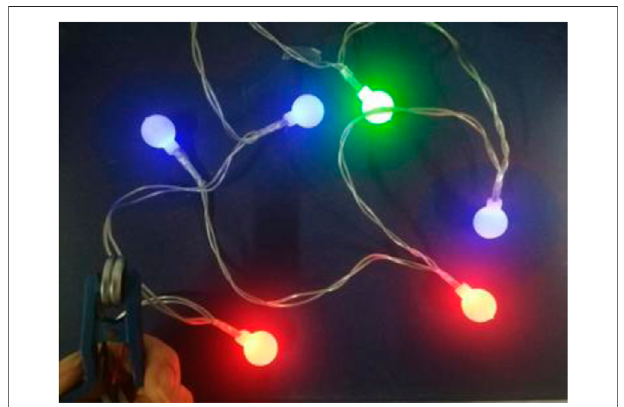
FIGURE 8 | Digital photograph of colored LEDs lighted by two 2 wt% MgO-coated NM